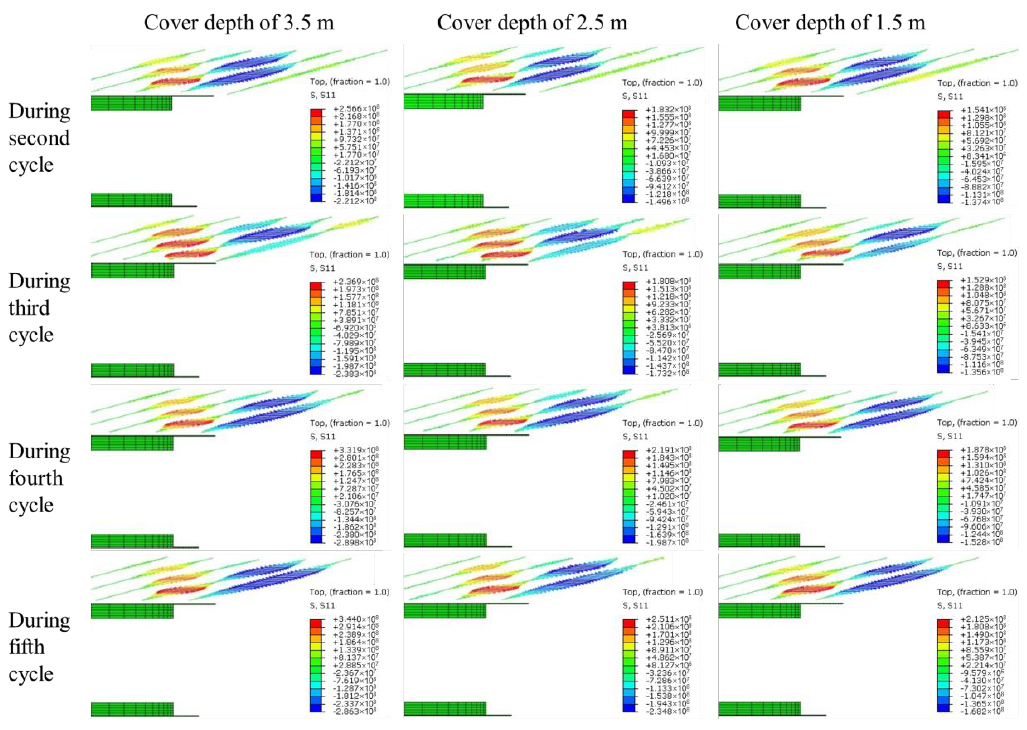
Figure 18. Stress acting on piles during Stage 1 of each construction cycle.